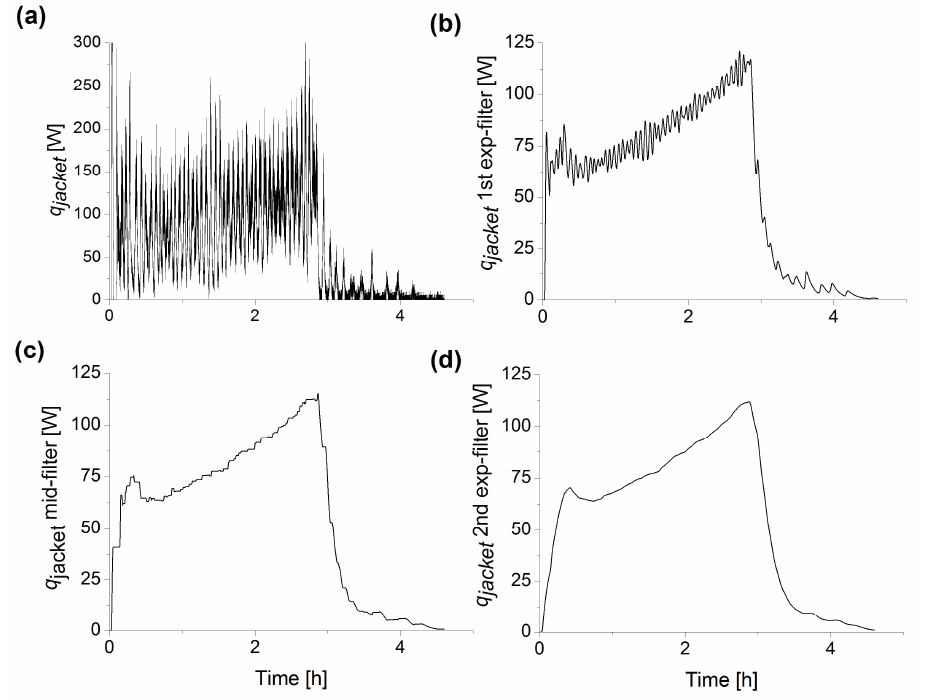
Figure 5. Effect of sequential signal filtering. ( a ) Unfiltered q jacket signal from model (Equation (3)); ( b ) Filtered q jacket signal after the first exponential filter with a filtering time of 300 s; ( c ) Filtered q jacket signal after the middle-value filter with a filter time of 420 s; ( d ) Filtered q jacket signal after the second exponential filter with a filter time of 300